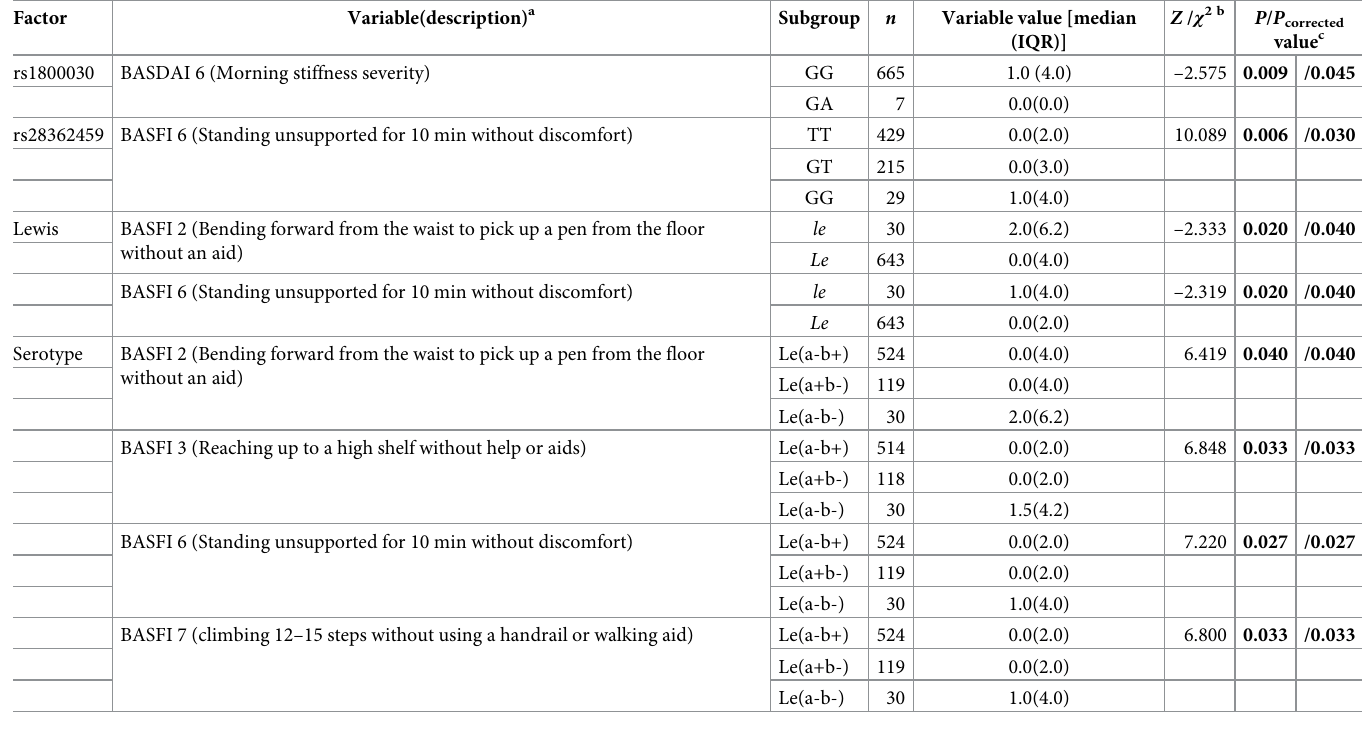
Table 5. Associations between FUT2/FUT3 gene polymorphisms and the indexes of AS.